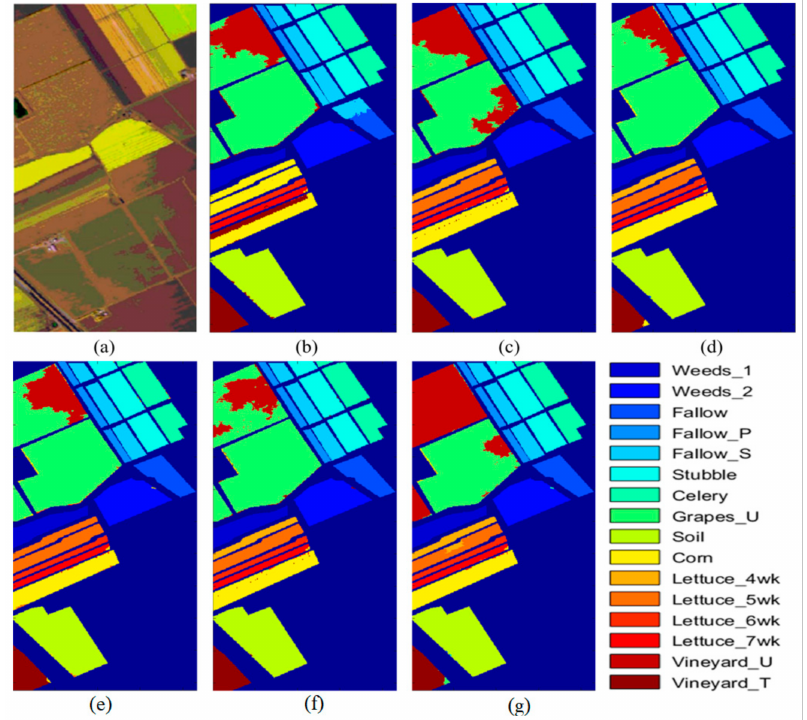
Figure 7. Slinas dataset. ( a ) False color image. The classification maps of ( b ) ANN, ( c ) CNN, ( d ) CRNN, ( e ) CNN-PPF, ( f ) SS-CNN and ( g )